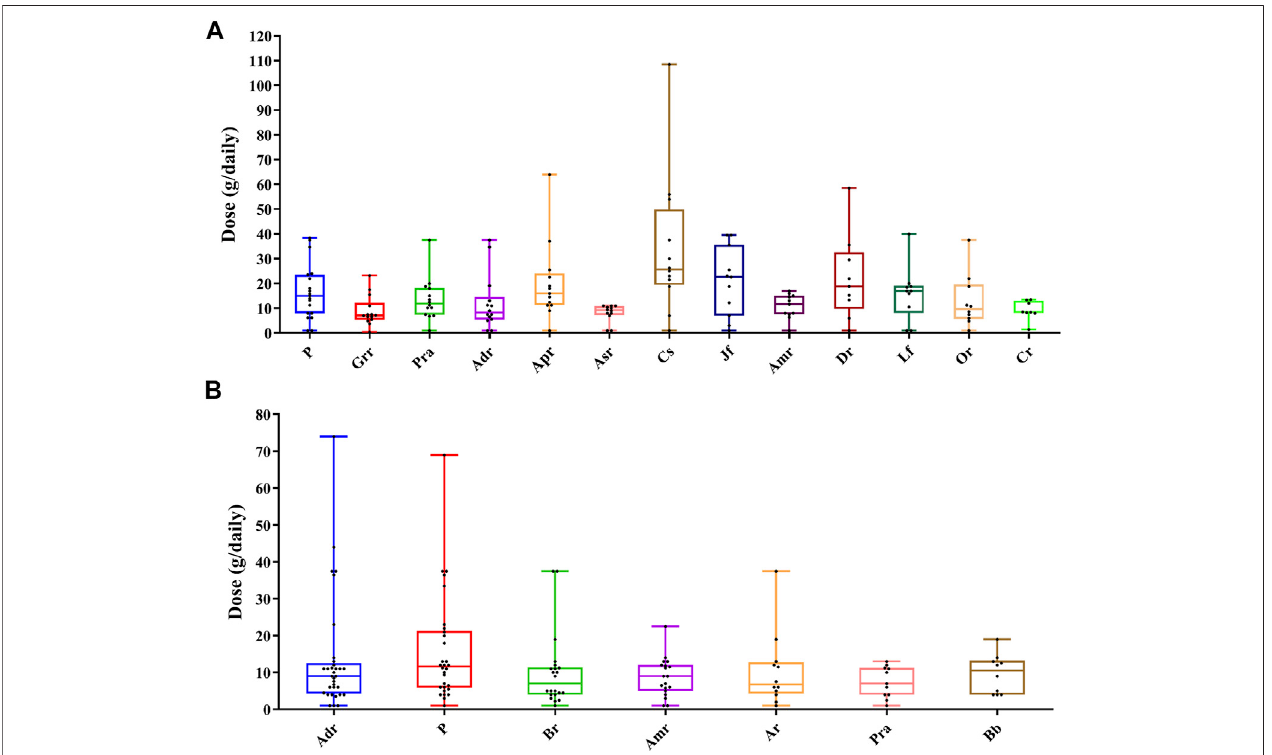
FIGURE 6 | Box plots of dose ranges of commonly used medicinal materials. The top line represents the maximum value, and the bottom line represents the minimumvalue;thebottomofeach boxrepresentsthe fi rstquartile(Q1),themiddlelinerepresentsthesecondquartile(Q2),andthetopofeachboxrepresentsthethird quartile(Q3).Theblackdotsrepresentthedosesinthecollectedsamples. (A) Oralprescriptionsand (B) externalprescriptions.Adr, Angelicadahurica (Hoffm.)Benth. & Hook. f. ex Franch. & Sav.; Amr, Atractylodes macrocephala Koidz; Apr, Astragalus propinquus Schischkin; Ar, Ampelopsis japonica (Thunb.) Makino; Asr, Angelica sinensis (Oliv.) Diels; Cr, Ligusticum striatum DC.; Cs, Coix lacryma-jobi var. ma-yuen (Rom.Caill.) Stapf; Dr, Dioscorea polystachya Turcz.; Grr, Glycyrrhiza uralensis Fisch.; Jf, Ziziphus jujuba Mill. (red); Lf, Lycium chinense Mill.; Or, Ophiopogon japonicus (Thunb.) Ker Gawl.; P, Wol fi poria extensa (Peck) Ginns; Pra, Paeonia lacti fl ora Pall.